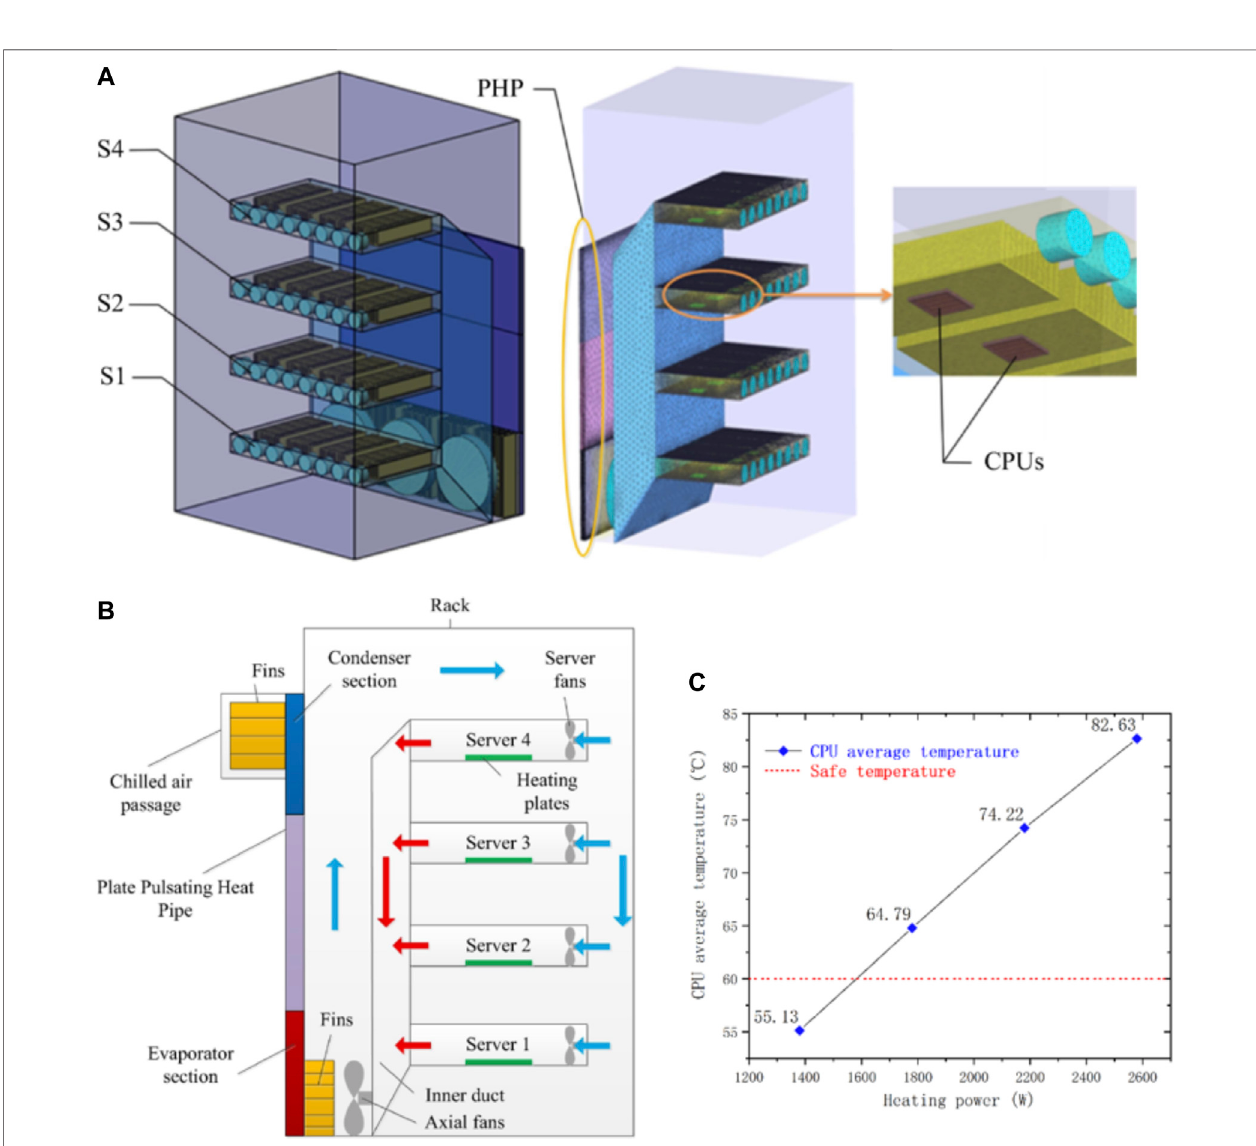
FIGURE 4 | (A) The overall view and (B) internal view of the enclosed rack heat dissipation system based on PHP, and (C) the CPU temperature variation under different rack heat loads (Chao et al., 2017).